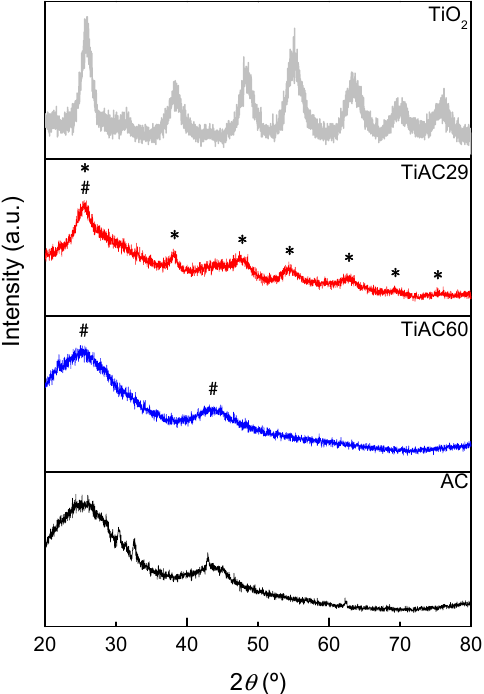
Figure 2. XRD patterns of the AC, TiO 2 and TiACX composites (#—characteristic peaks of AC component; *—peaks assigned to TiO 2 component within the composites).